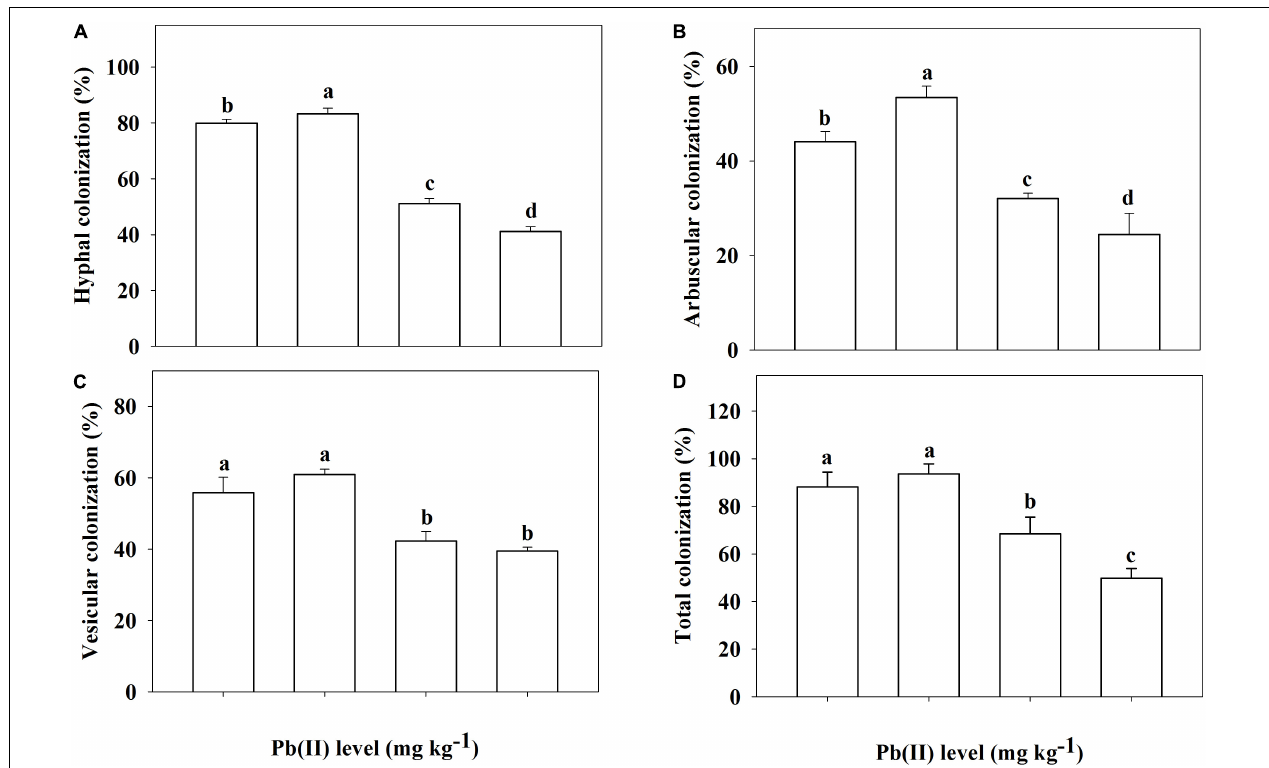
FIGURE 2 | Root colonization of Robinia pseudoacacia seedlings by Funneliformis mosseae being subjected to different Pb levels for 4 months. (A) Hyphal colonization; (B) Arbuscular colonization. (C) Vesicular colonization. (D) Total colonization. Shown are means ± SD ( n = 3). Different lowercase letters indicate significant differences among different Pb levels within the inoculated treatment ( P < 0.05; ANOVA with post hoc Duncan).